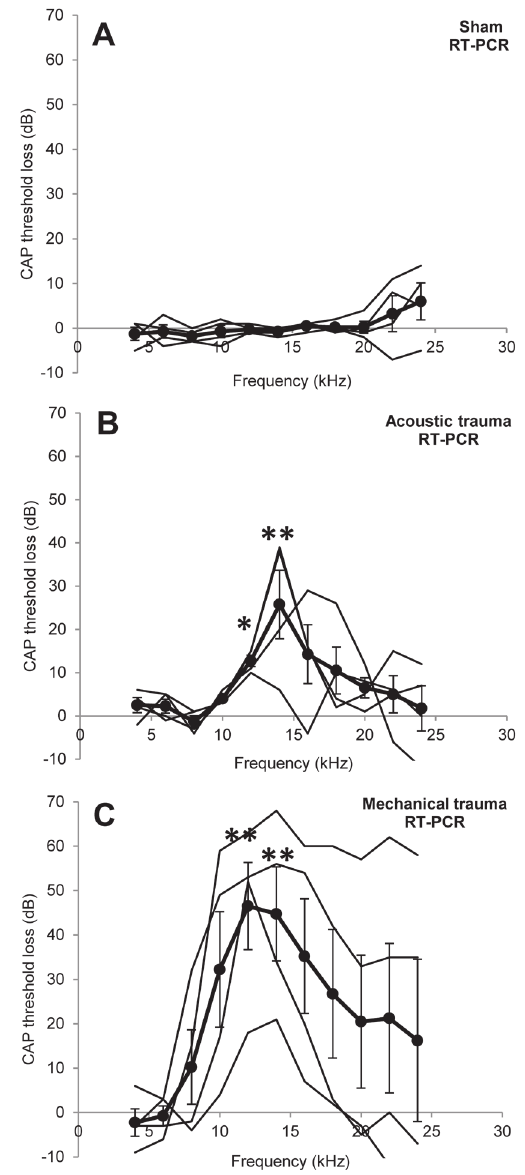
Figure 1. Peripheral hearing loss. Changes in cochlear sensitivity measured as CAP threshold loss recorded in the left cochlea after recovery from sham surgery ( A ), acoustic trauma ( B ) or mechanical trauma ( C ). Thick black lines indicate the mean ± SEM (n=4 for all), thin black lines represent individual animals. * p <0.05, ** p <0.01 compared to before treatment